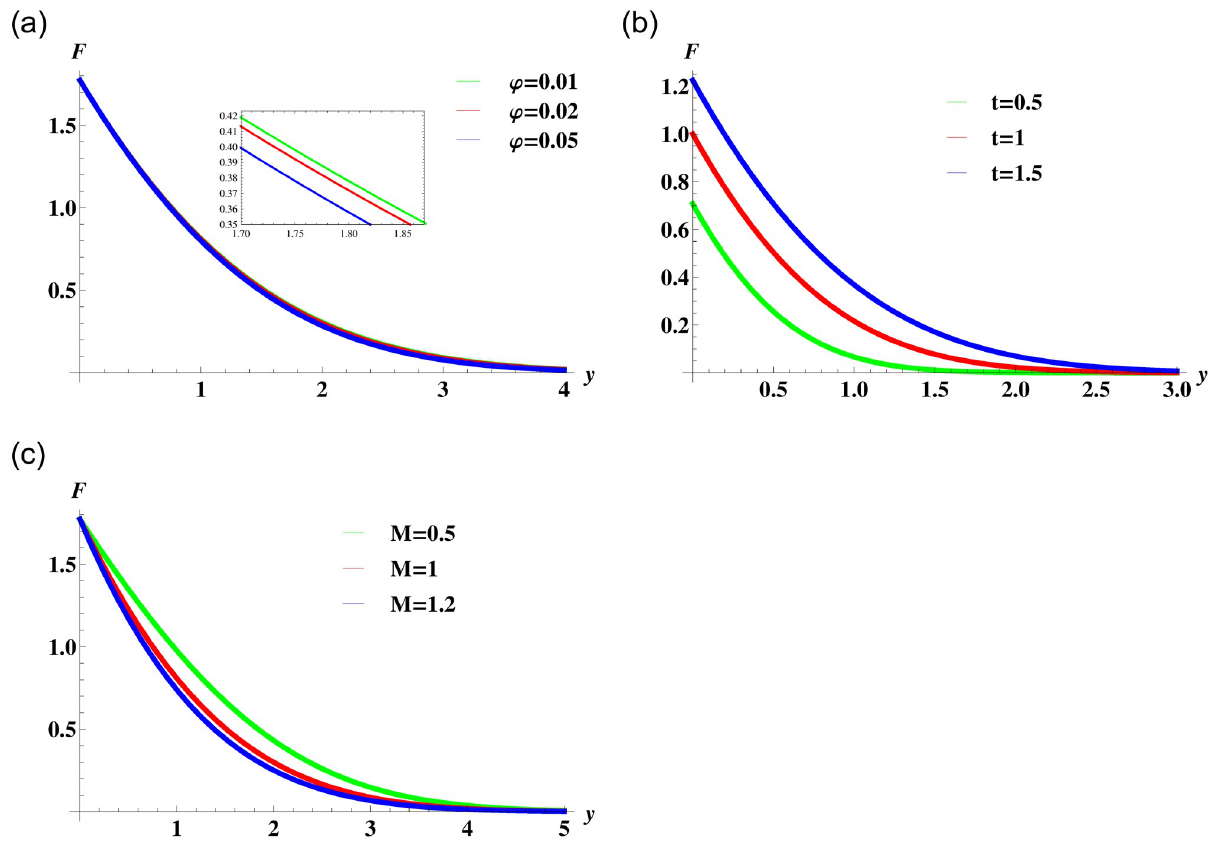
Fig 3. Velocity profile (42) for various values of φ , t and M when ρ